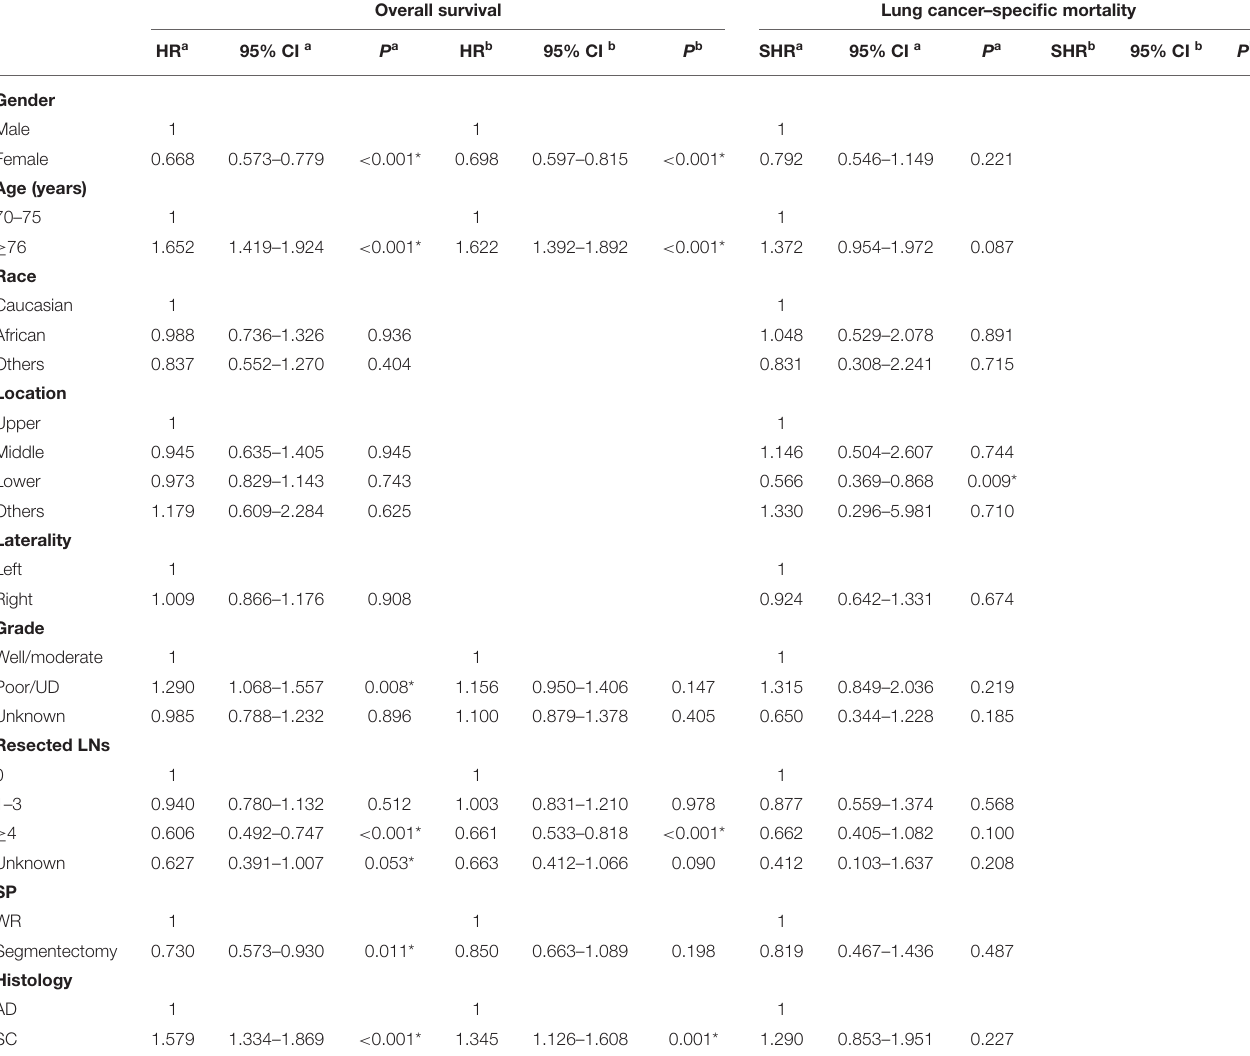
TABLE 3 | Survival comparisons for patients with TS ≤